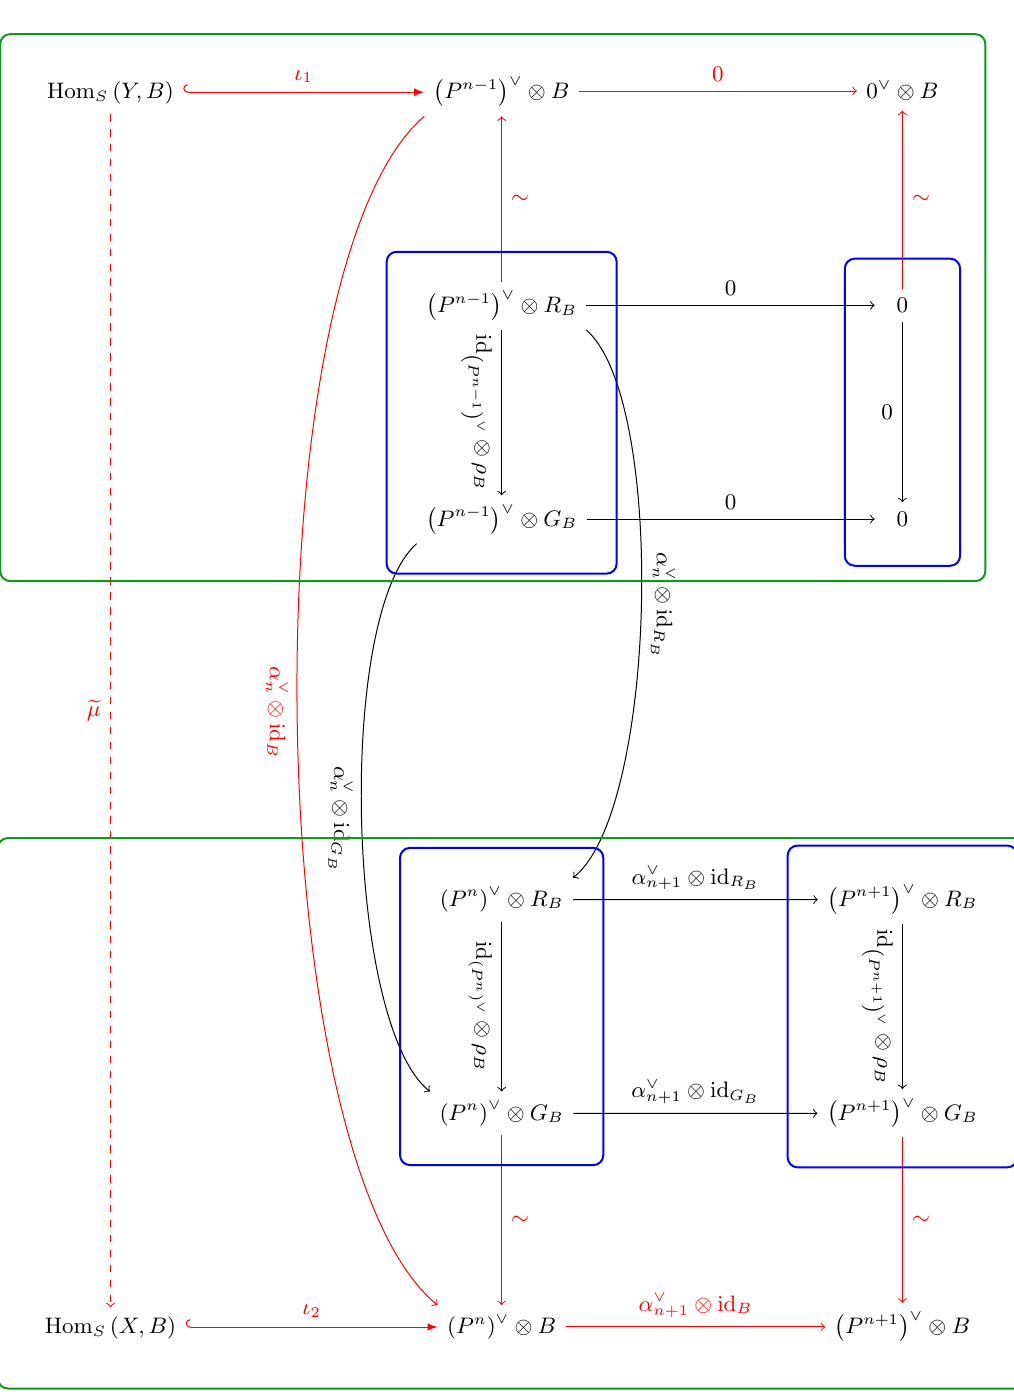
(cid:22) : Hom S ( Y; B ) ! Hom S ( X; B ) based e